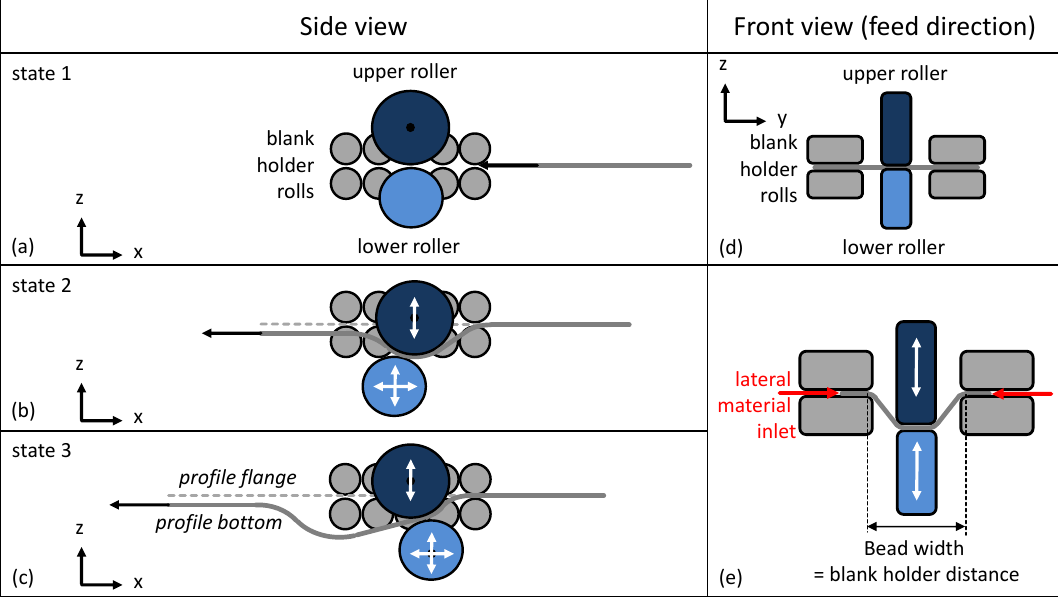
Figure 2. Process principle and degrees of freedom of a flexible roller beading stand.